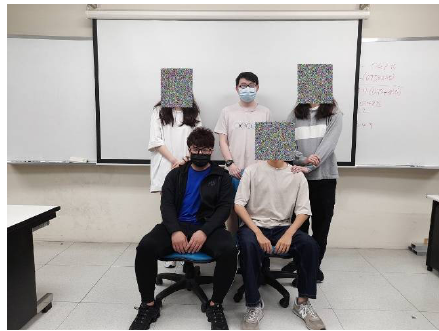
Figure 3. The encrypted result.